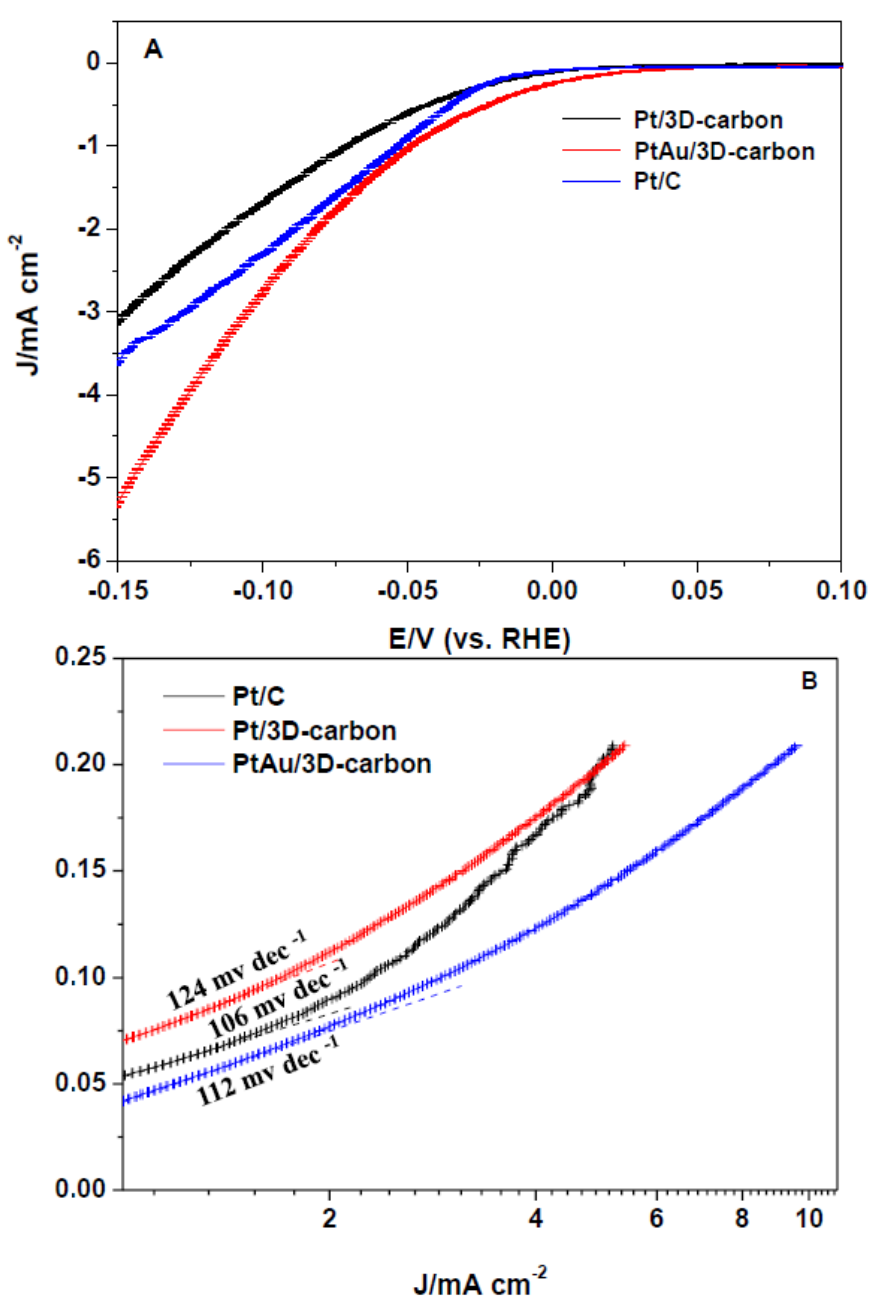
Figure 5. ( A ) the polarization curves and ( B ) corresponding Tafel plots of PtAu/3D carbon, Pt/3D carbon, and commercial